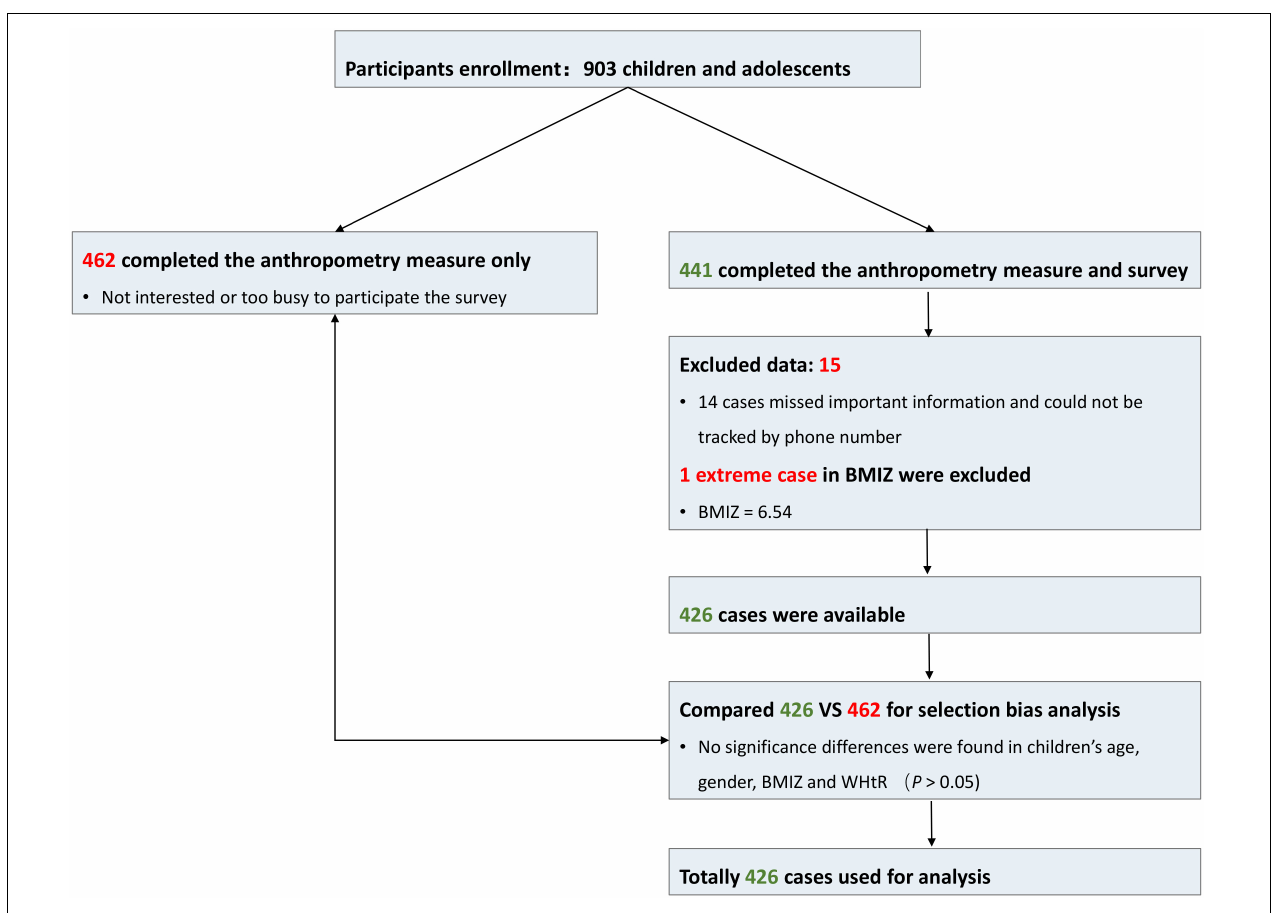
FIGURE 2 | Participant recruitment and retention. BMIZ, body mass index Z score; WHtR, waist-to-height